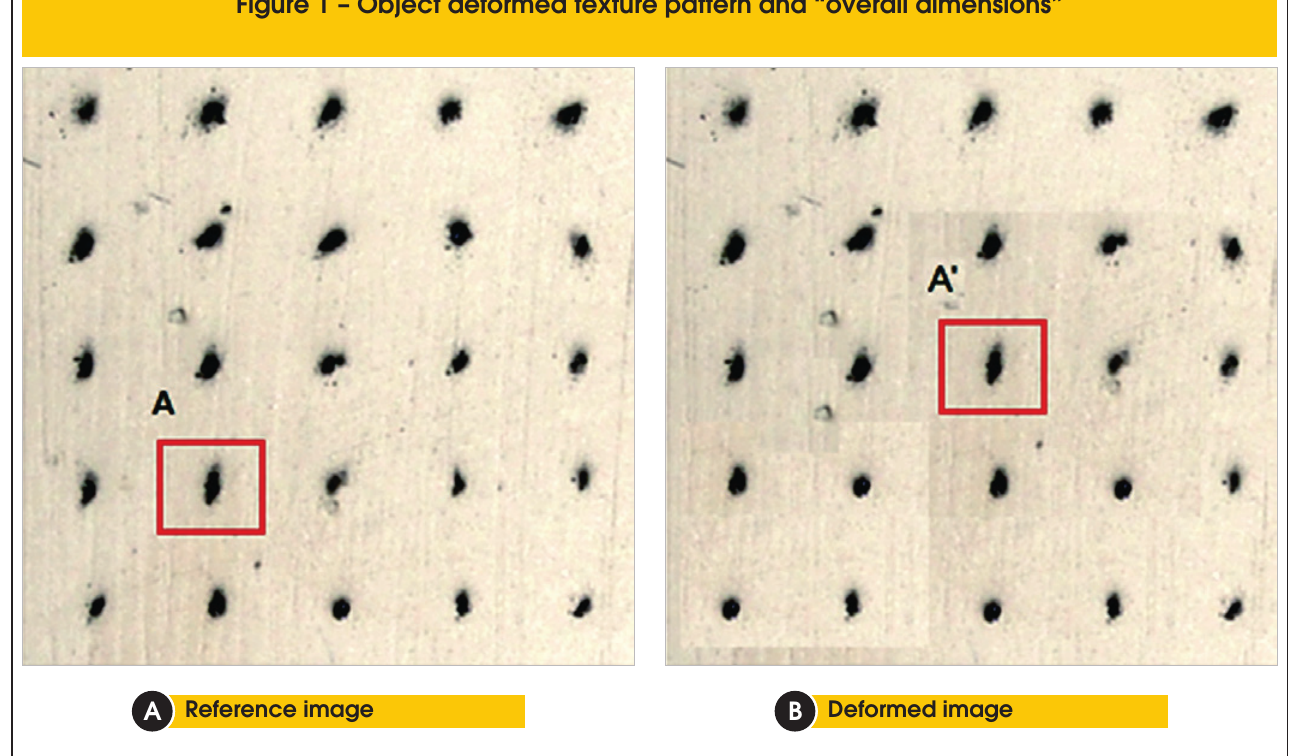
Figure 1 – Object deformed texture pattern and “overall